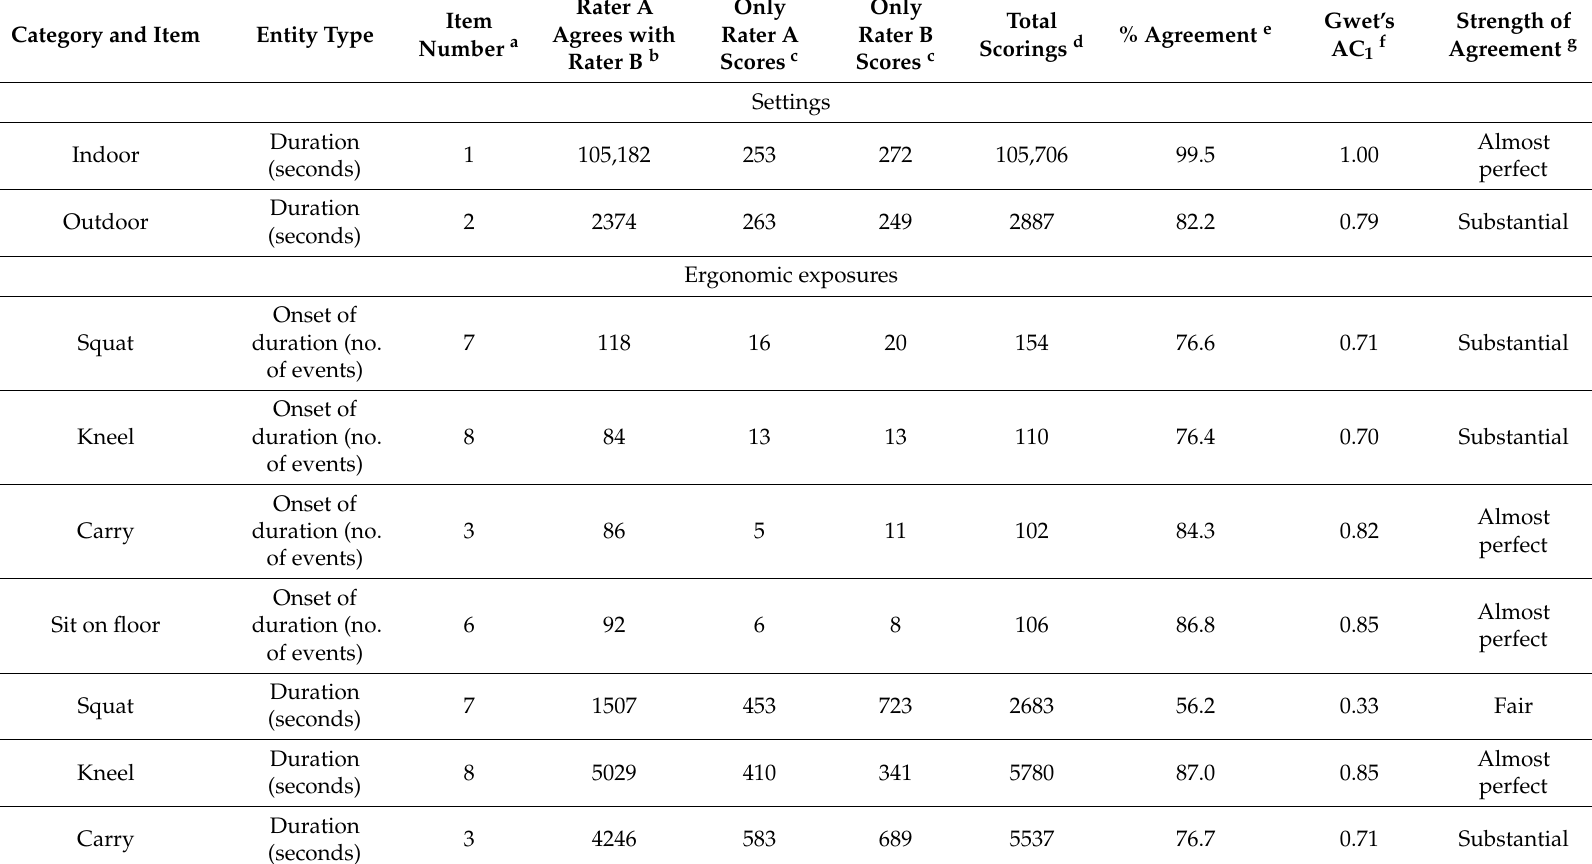
Table 3. Inter-rater reliability of ergonomic work demands items in the TRACK observational instrument, expressed as the percentage of agreement (%) between rater A and B, agreement coe ffi cient (Gwet’s AC 1 ) and strength of agreement. The item Manual handling is generated from the items Lift (item no. 4) and Push, pull, partial lift (item no.